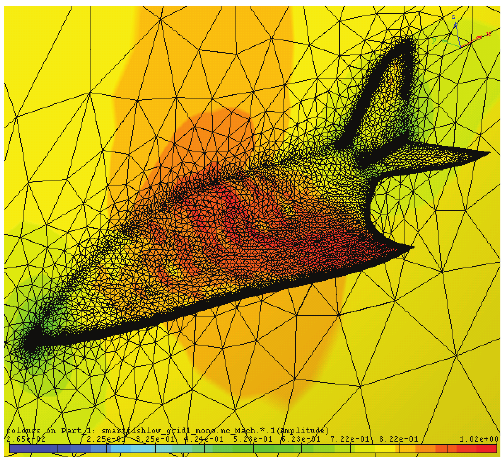
Figure 17: Adapted coarse grid with respect to the Mach gradient. 2 adaptation cycles only with refinement at the Mach number 0.8 and angle of attack 2 ◦ , 6569277 elements and 1 098 081 nodes.